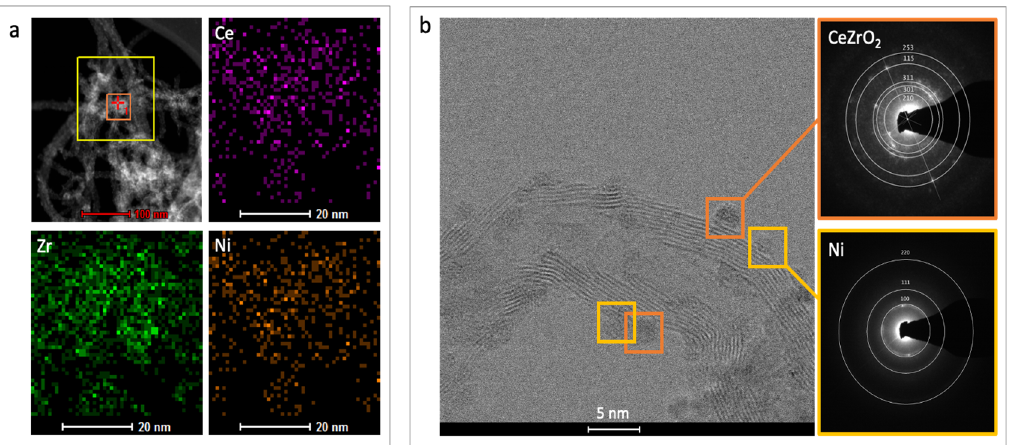
Figure 5. The Ce, Zr and Ni mapping for NiCZ/CNT ( a ) and selected area electron diffraction for Ni